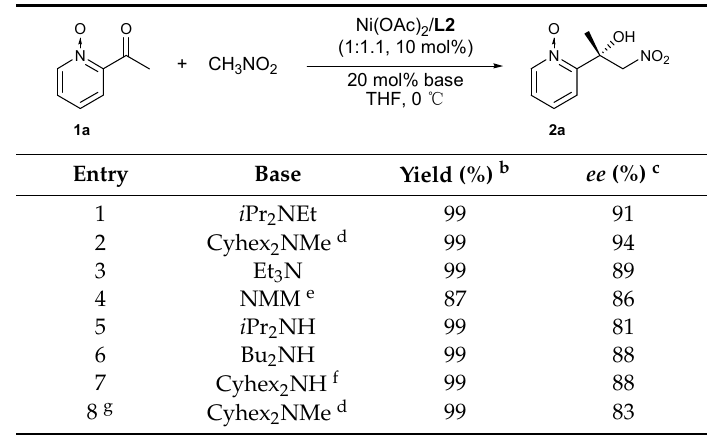
Table 2. Further optimization of the reaction a .